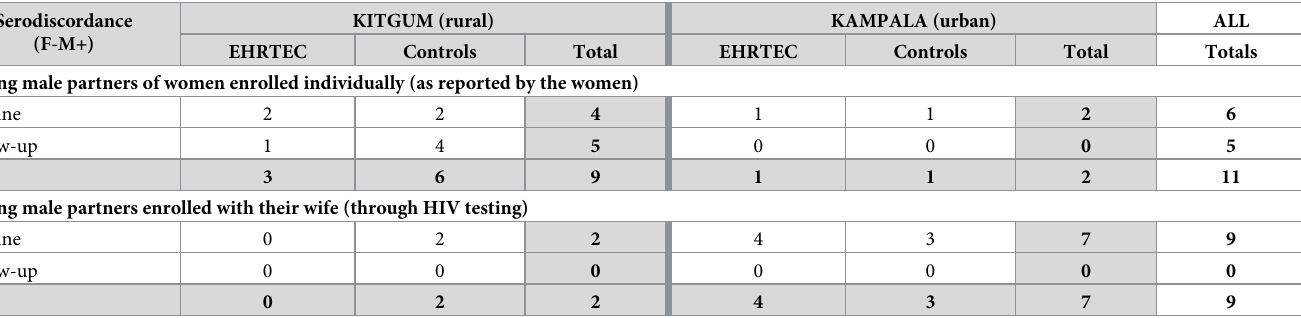
women in both arms reporting to have used a condom at last sex steadily increased from enrol-